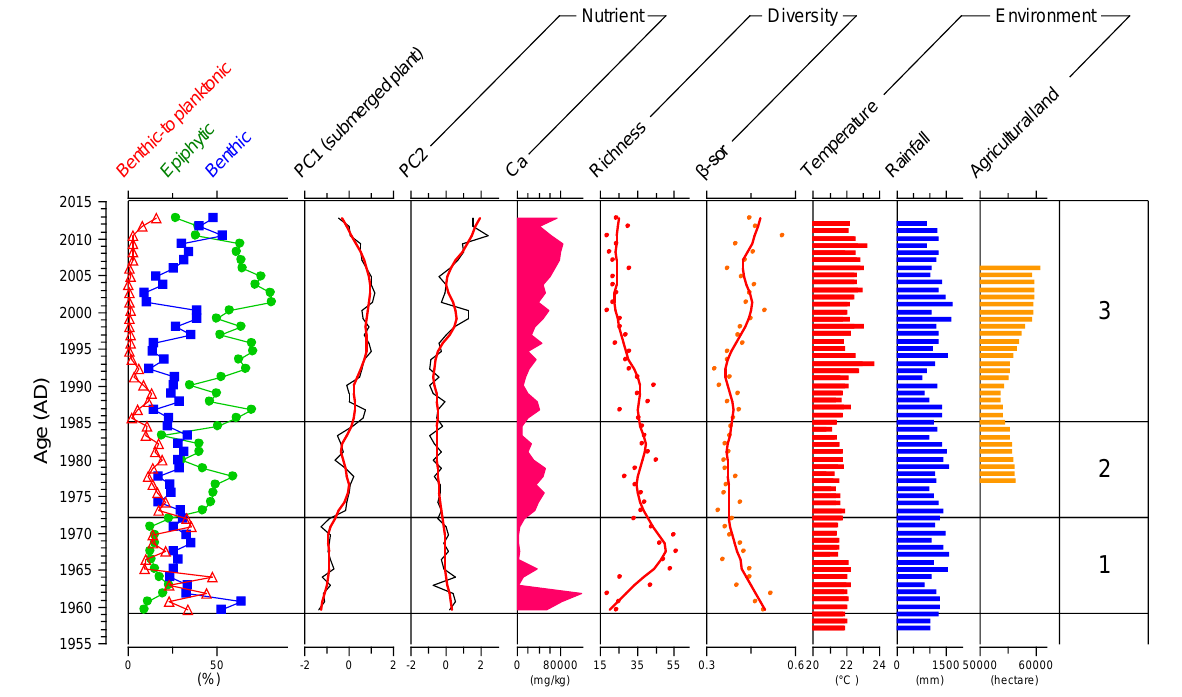
Figure 7. Summary of diatom habitat preference (benthic-to-planktonic, epiphytic, and benthic), submerged macrophyte coverage (PC1), nutrient concentration (PC2, Ca), diversity estimates (rich- ness, β -sor), and environmental factors (temperature, rainfall, and agriculture land), as inferred from sedimentary proxies and historical records for 1960 – 2013.